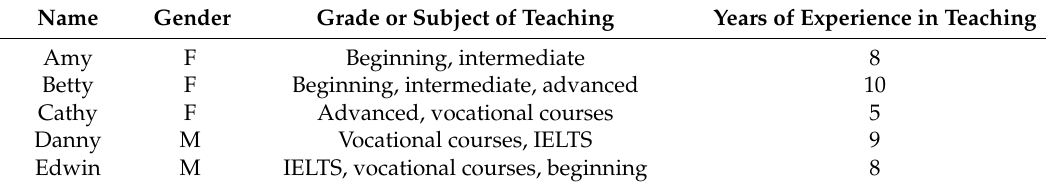
Table 1. Demographic information for the participants. F, Female, M, Male.